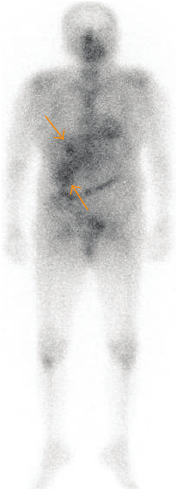
Figure 6: Gallium-67 scintigraphy. Two prominent hot spots were revealed in the